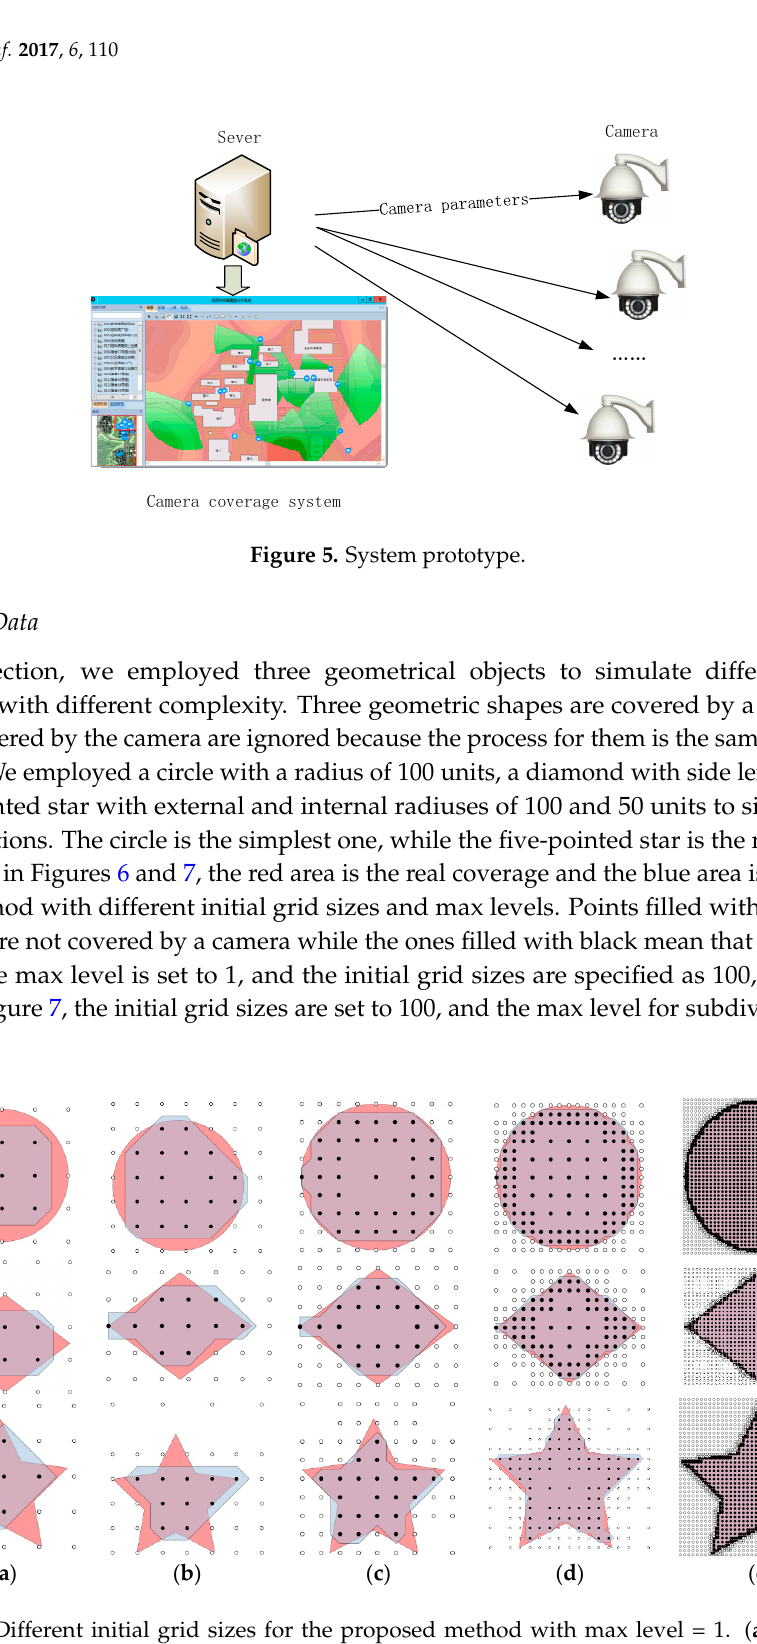
( d ) Figure 7. Different max levels for the proposed method with initial grid size = 100. ( a ) level = 1; ( b ) level = 2; ( c ) level = 3; ( d ) level = 4. The results of experiments with different initial grid sizes and max levels are shown in Figures 8–10. In these figures, the point number stands for efficiency, which is represented by the number of points needing to be judged for whether they are covered by the camera. The coverage rate stands for accuracy, which is represented by the percentage of the coverage area relative to the real area.